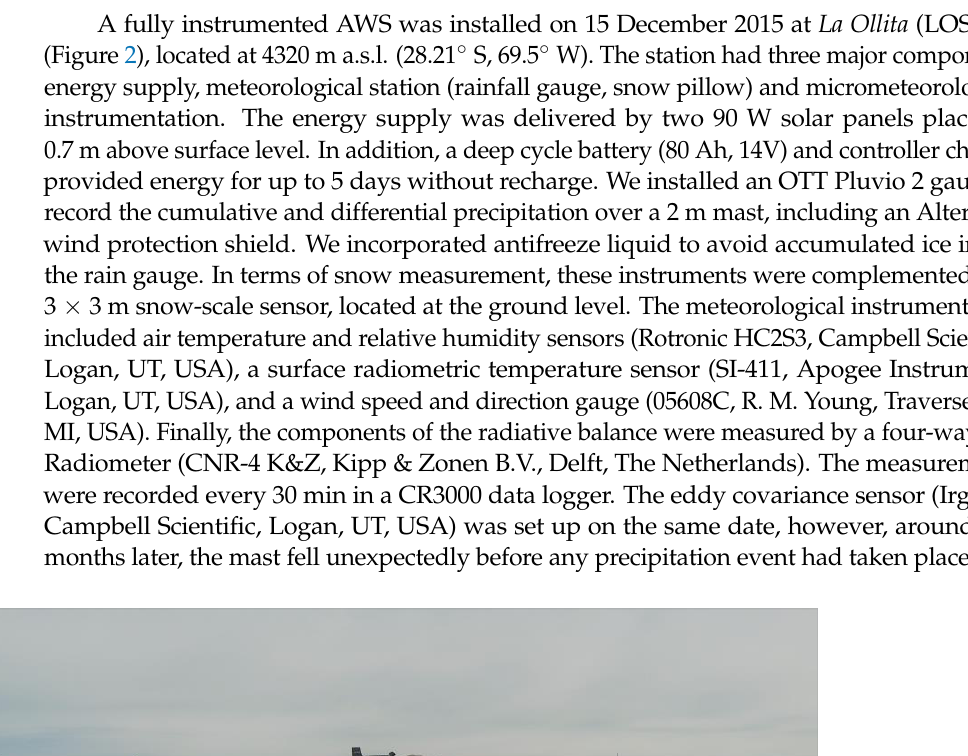
Figure 1. Location of the Upper Copiapó river basin and its three tributaries; from north to south, Jorquera river basin, Pulido river basin and Manflas river basin.